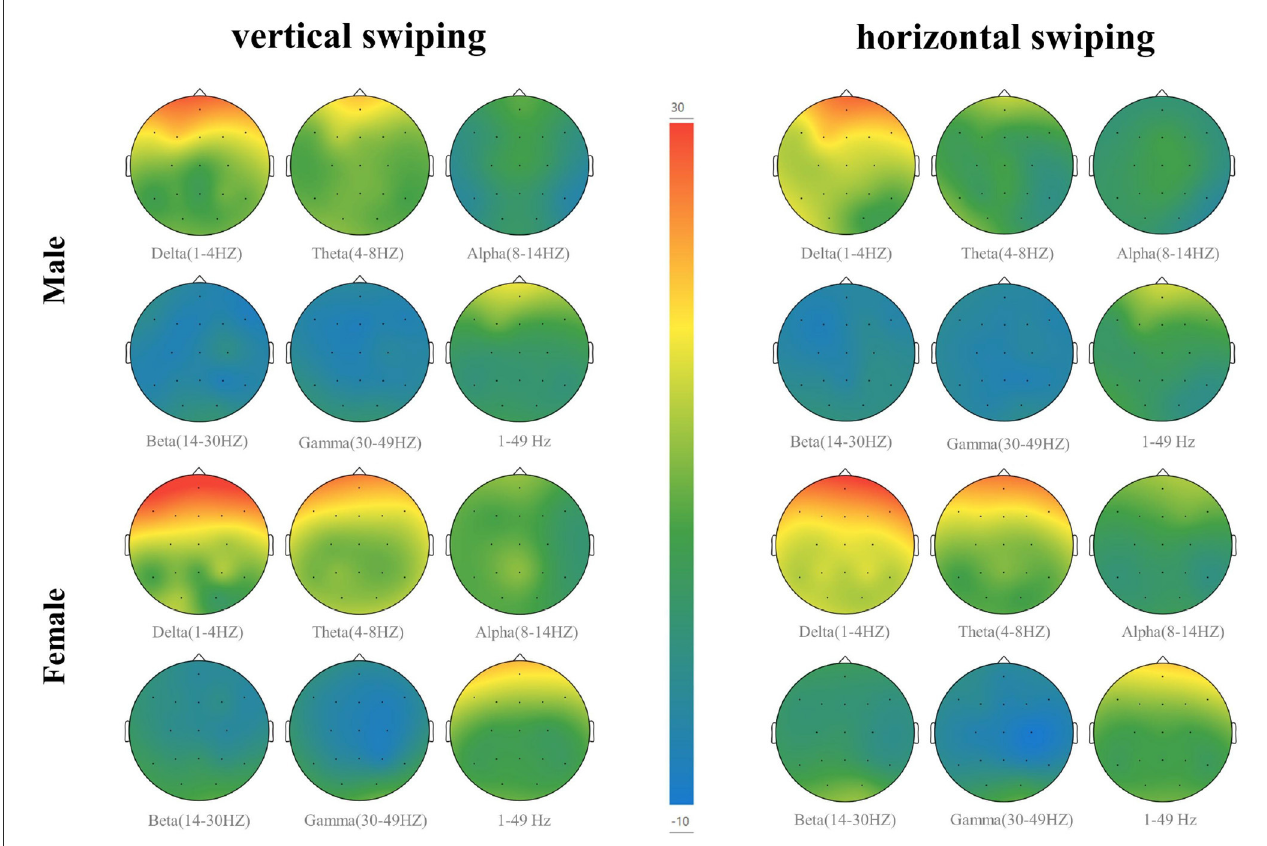
FIGURE8 EEG topography based on different frequency bands. The mean power changes of participants in each band during vertical versus horizontal swiping were